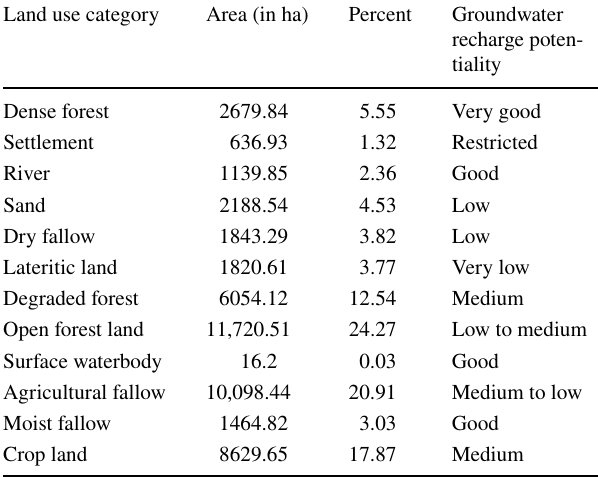
Table 2 Land use/land cover characteristics and their areal extent of